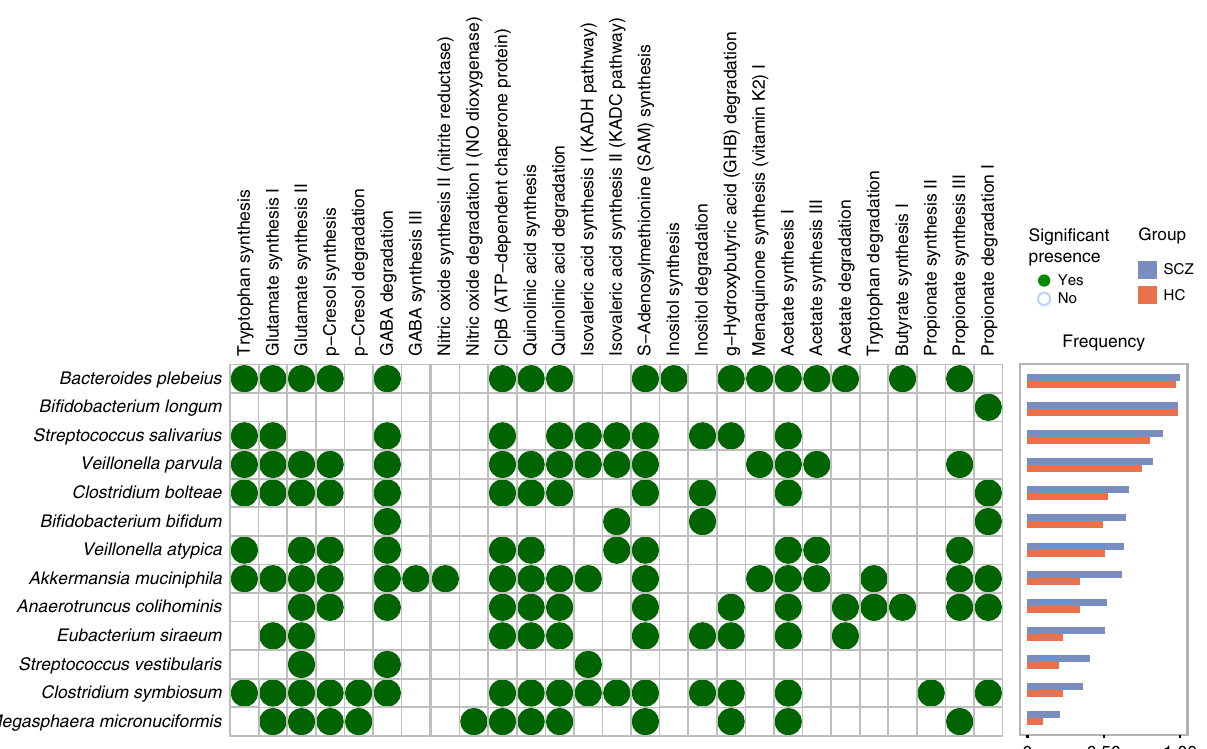
Fig. 2 The gut-brain modules present in schizophrenia-associated bacterial species. A green dot indicates a statistically signi fi cant association between a gut-brain modules present in schizophrenia-associated bacterial species and a metabolite. No dot represents a non-signi fi cant association or a non-existent association. The difference in relation to presence between schizophrenic patients and heathy controls was calculated (Chi-square test, P < 0.05). The bar plot shows the frequency of each bacterial species present in schizophrenic patients (SCZ, blue bar) and healthy controls (HC, red bar), respectively. See detailed statistical data in supplementary Source Data fi